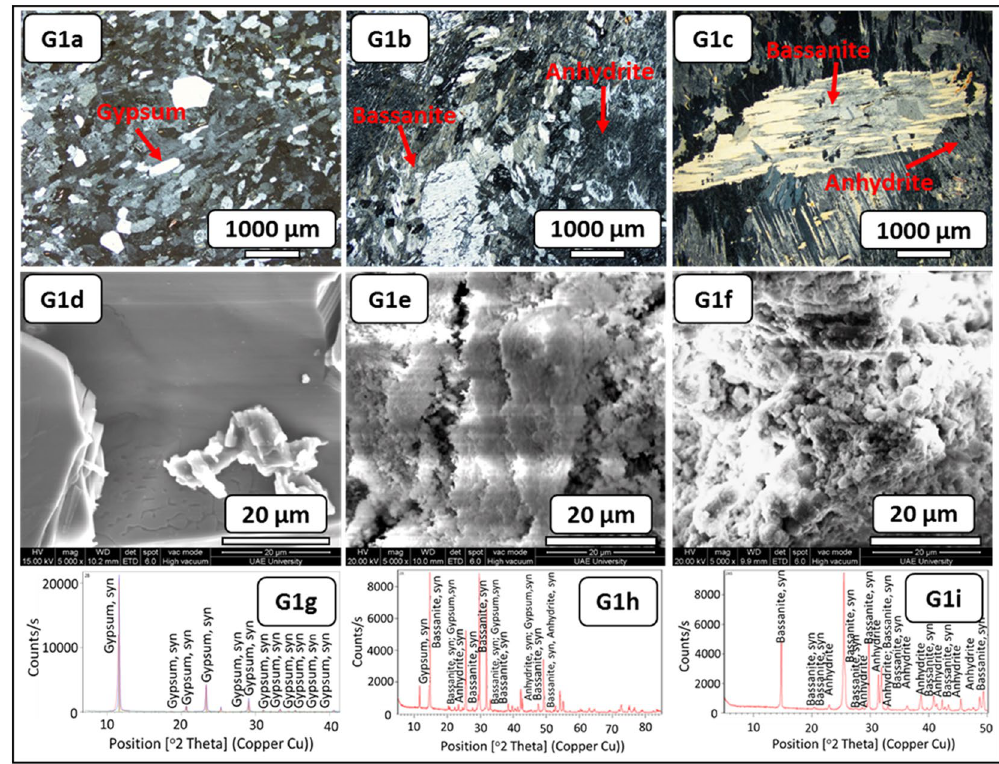
Figure 7. Microscopic description, SEM and XRD of an evaporitic rock Group 1 (fresh sample, after slaking with distilled water and groundwater respectively). G1a-G1c represents thin section images under cross- polarized microscope showing mega crystalline pure prismatic gypsum crystals before SDI and fibro-radiating basanite intergrowth with microcrystalline anhydrite after SDI test. G1d-G1f. represents SEM images showing tabular gypsum and needle shaped before SDI with interspersed in a loose fabric and filling anhydrite in the microfractures after SDI test. G1g-G1i represents XRD analyses showing dominant of gypsum before SDI test where after SDI dominance of hemihydrate- dehydrated calcium